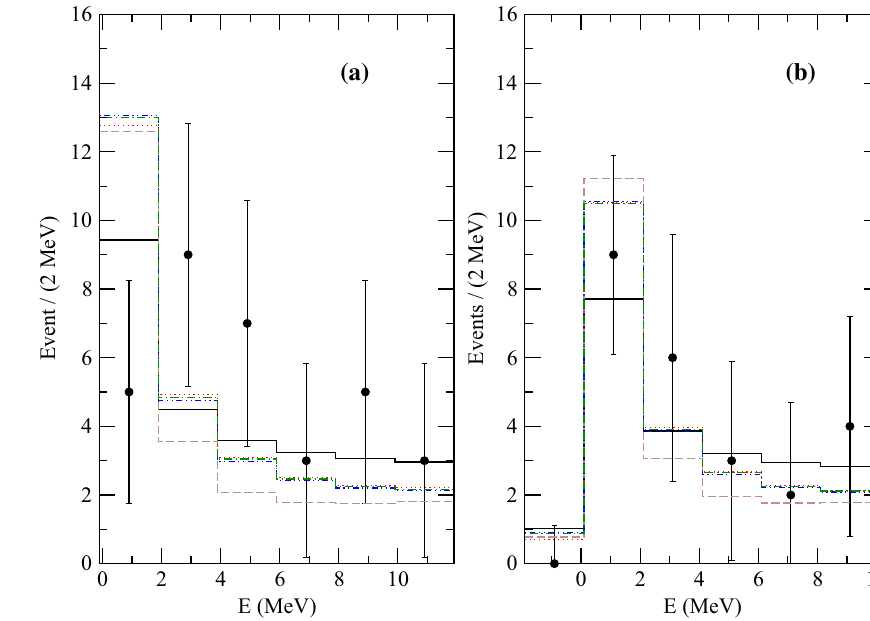
Fig. 5 Detail of the fit results for the near-threshold region in the D 0 ¯ D ∗ 0 event